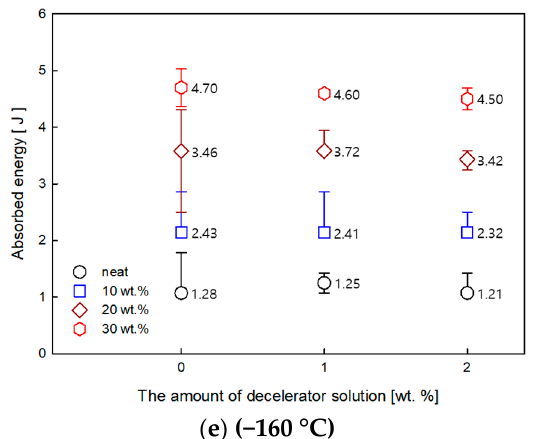
Figure 6. Impact strength of neat and GF/DCPD composites as a function of temperature with different amounts of decelerator. (a) Room Temperature, (b) − 20 °C, (c) − 60 °C, (d) − 110 °C, (e) − 160 °C